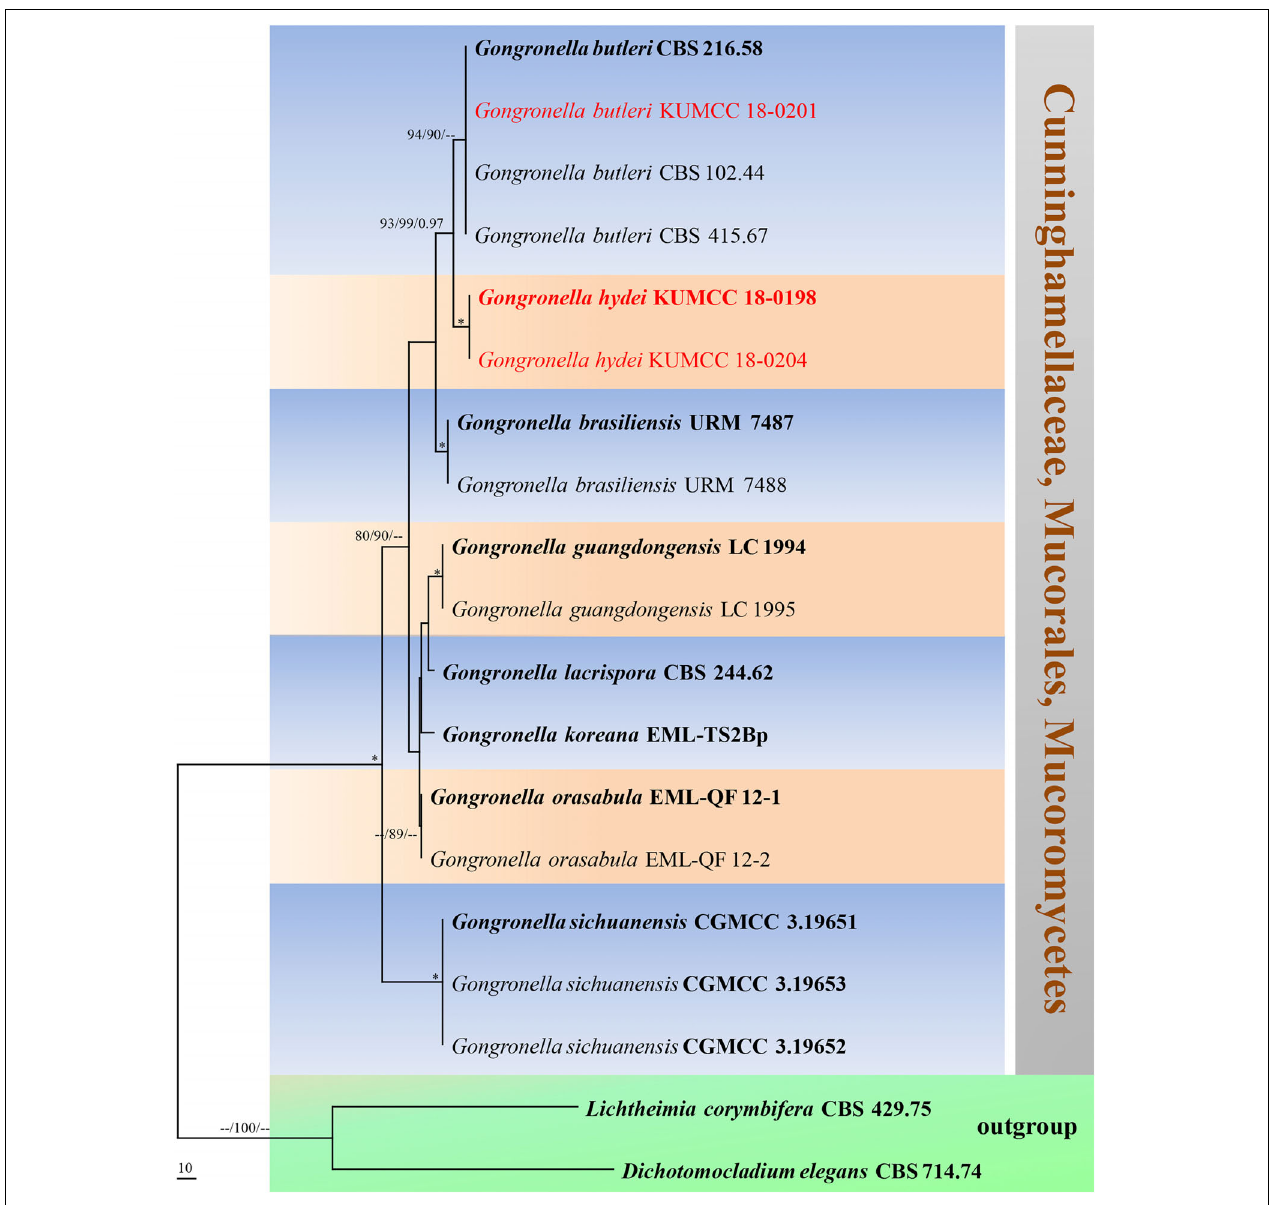
FIGURE 9 | Phylogram generated from maximum parsimony analysis based on ITS sequence data. Nineteen sequences are included in the ITS analysis, which consisted of 772 characters including alignment gaps. The tree is rooted to Lichtheimia corymbifera (CBS 429.75) and Dichotomocladium elegans (CBS 714.74). The MP analysis for the ITS dataset had 187 parsimony informative, 315 constant, 270 parsimony uninformative characters and yielded two most parsimonious trees. The best-fit model GTR + G was selected for ITS. Maximum parsimony and maximum likelihood bootstrap values ≥ 70% and Bayesian posterior probabilities ≥ 0.90 (MPBS/MLBS/BYPP) are given at the nodes. The ex-type strains are bolded, and the new isolates are in red. Branches with 100% MPBS, 100% MLBS and 1.00 BYPP values are indicated as an asterisk ( ∗ ).